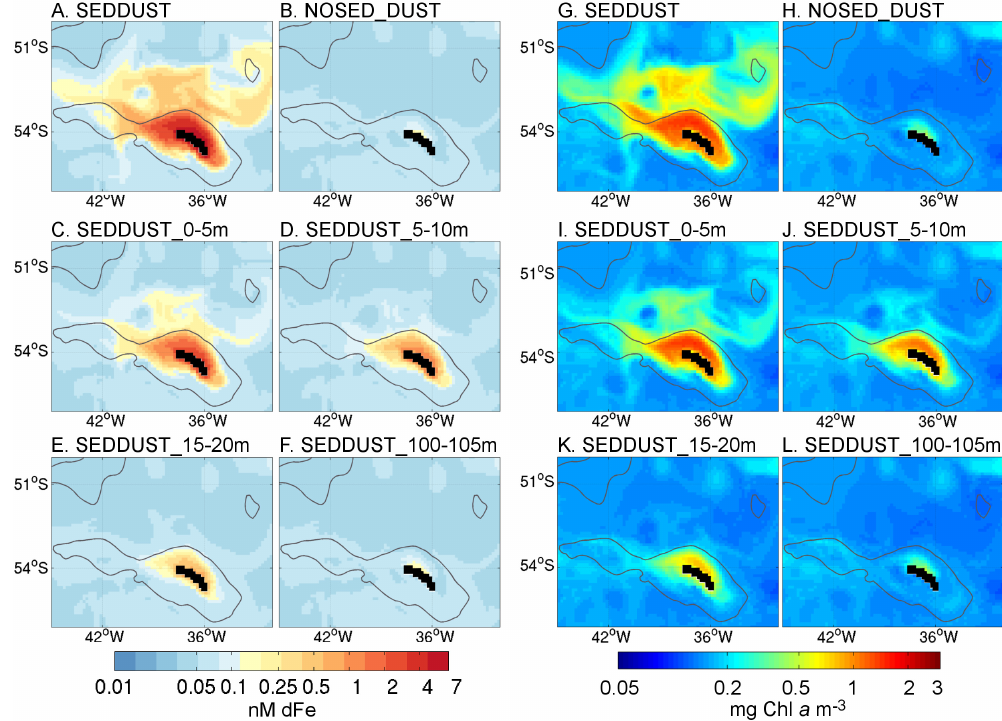
Fig. 10. Surface (0–30m) dFe concentrations (panels a–f on the left) and Chl a concentrations (panels g–l on the right) for January–February of the last modelling year obtained with simulations, including different sedimentary sources of iron. Results for the reference runs (i.e. SEDDUST and NOSED_DUST) are shown in the first row. See also Table 1 and Sect. 2.3 for further details on each